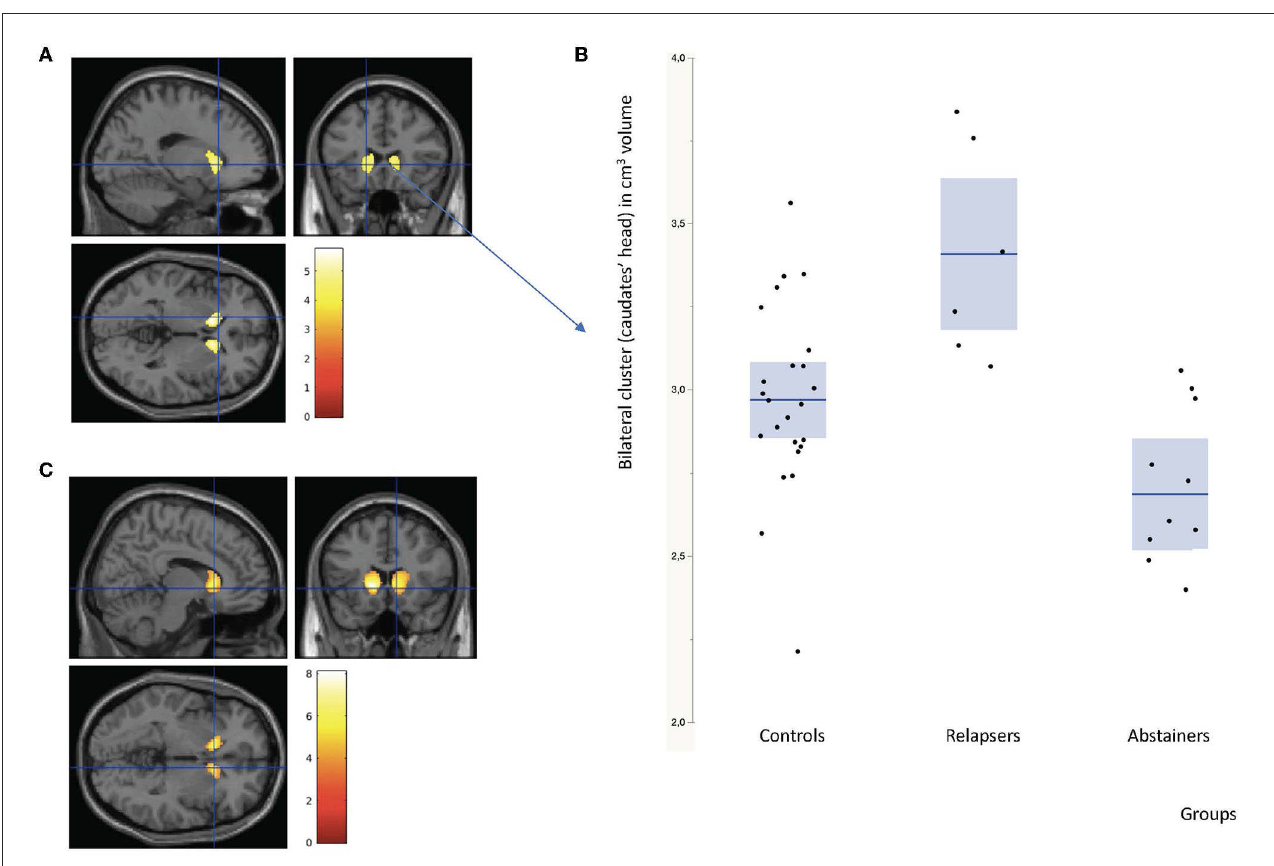
FIGURE1 (A) Gray matter volumes: cross-sectional bilateral caudate nuclei increases in relapsers compared to abstainers Alcohol Use Disorders (AUD) patients, at baseline (height and extent threshold p < 0.05 FWE corrected). (B) Individual plots: bilateral heads of the caudate nuclei cluster volumes (in cm 3 ) at baseline in controls on the left, relapsers on the middle and abstainers on the right. (C) Idem at follow-up (height threshold p < 0.001 uncorrected and extent threshold p < 0.05 FWE